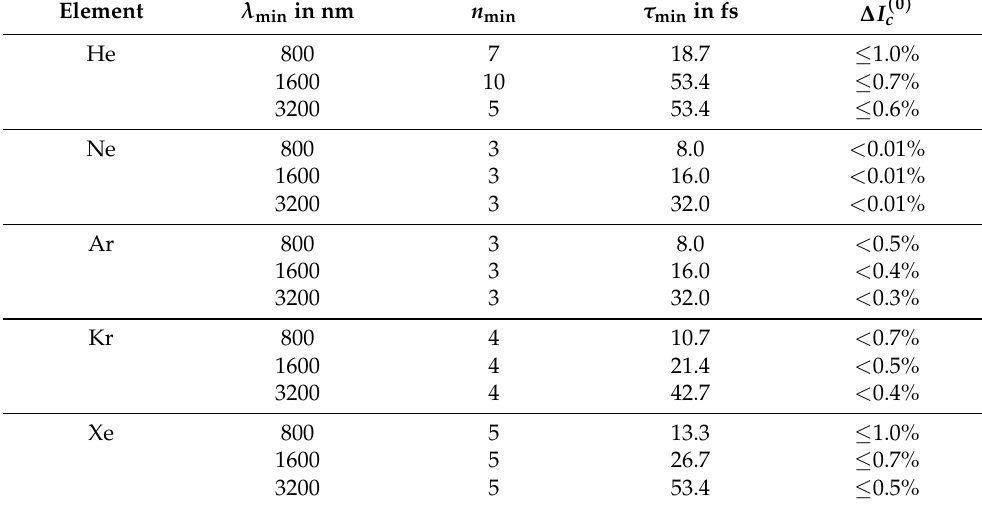
Table 2. Accuracy of the critical intensity in the ADK model (40). The table is showing the lower limit of the parameters λ min , n min , τ min ∝ λ min n min (wavelength, number of optical cycles, pulse ( 0 ) duration) for which the error of the critical intensity is smaller than ∆ I c . The error decreases for any configuration of higher parameters. We fixed the HH photon energy to 50eV such that the error of the critical intensity remains roughly constant for higher photon energies and changes reasonably slowly for lower photon energies, such as the critical ionization probability in Figure